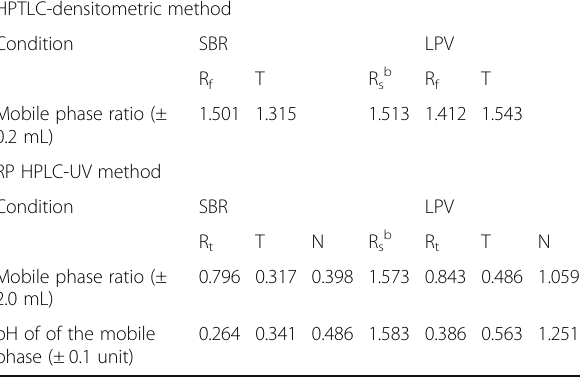
Table 4 Robustness testing a of the adopted chromatographic methods for the simultaneous estimation of SBR and